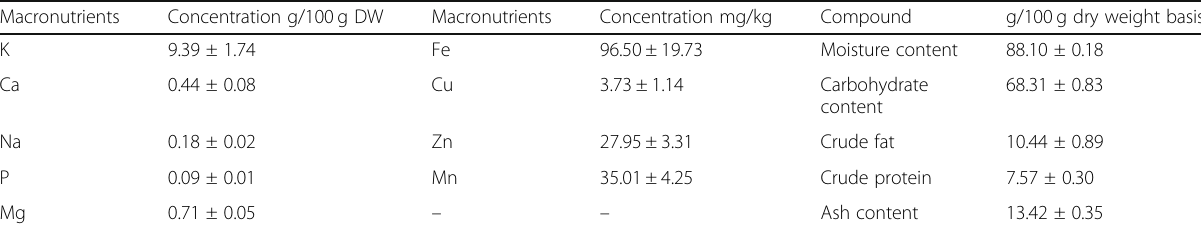
Table 4 Nutrient content in banana peel (Aboul-Enein et al. 2016) Macronutrients